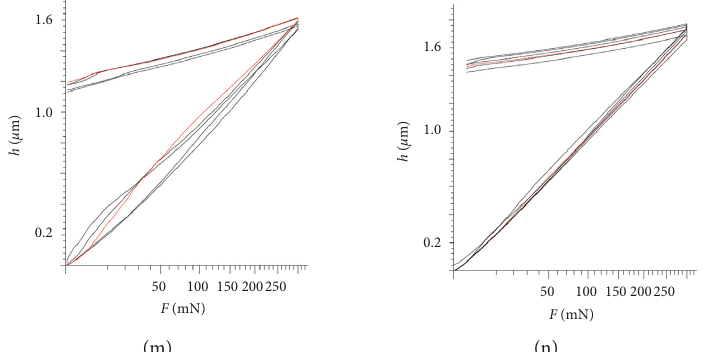
Figure 10: Load-displacement curves for consolidated bulk nanocrystalline composites: Ta-5Y